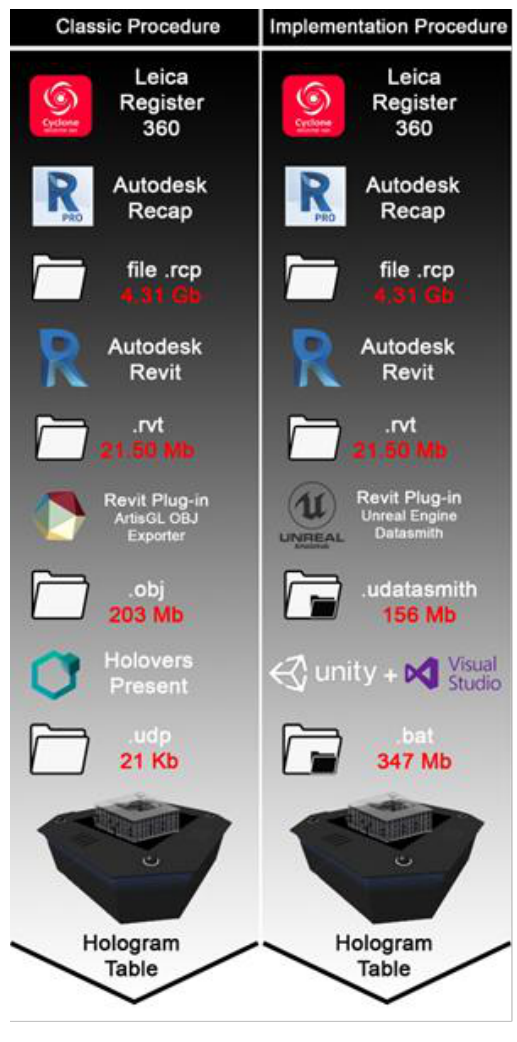
Figure 8 . Traditional workflow vs Implementation – Unity